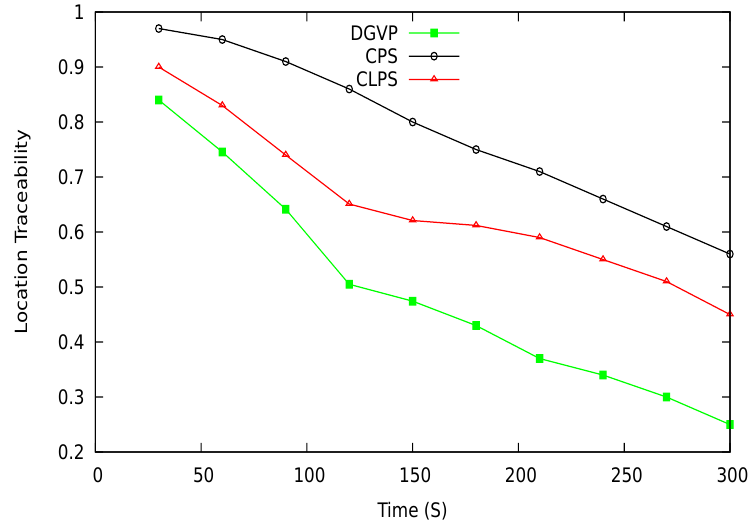
Figure 19. Location traceability at different